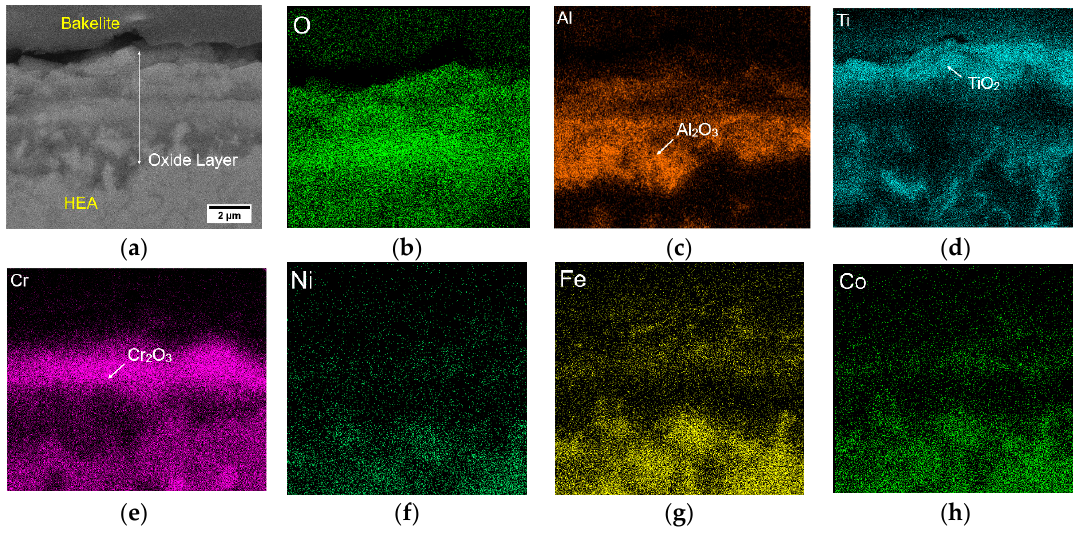
Figure 11. ( a ) Backscattered electron image and the corresponding ( b ) O, ( c ) Al, ( d ) Ti, ( e ) Cr, ( f ) Ni, ( g ) Fe and ( h ) Co EDS maps of the oxide scales on AlCoCrFeNiTi 0.5 HEA oxidized at 800 °C for 45 h.